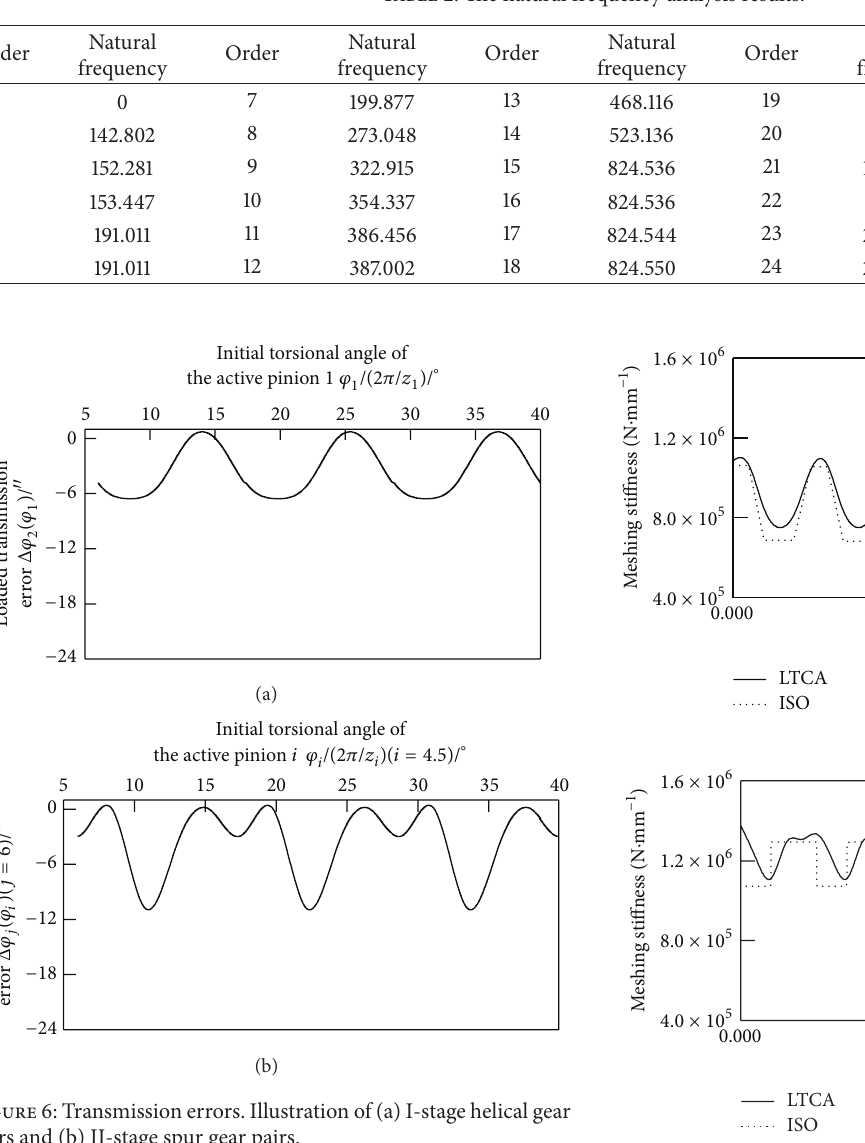
Table 2: The natural frequency analysis results.